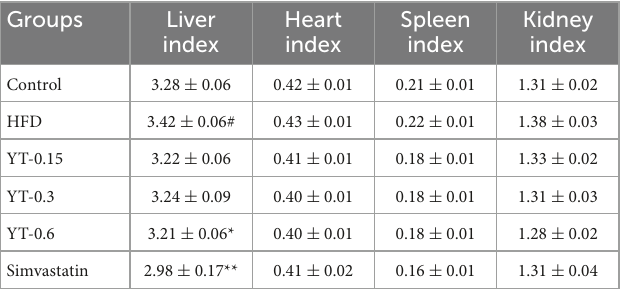
TABLE 2 Effects of YT extract on the liver, heart, spleen, and kidney indices (X ± SEM, n = 6).